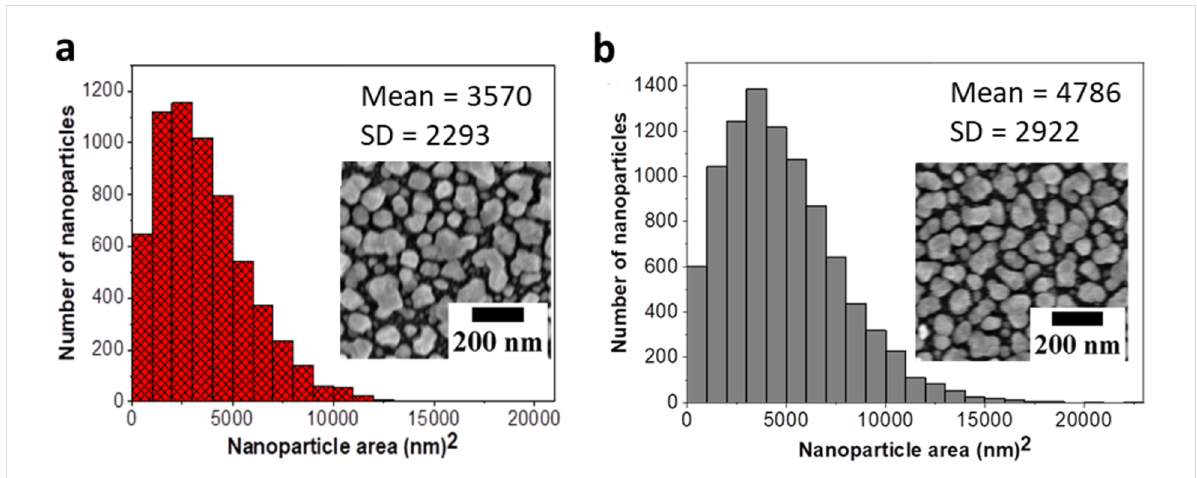
Figure 2: Particle size distributions and SEM images of the microwave-fabricated SERS substrates (a) after synthesis and (b) after immersion in water for 1 h. Data were acquired on different substrates prepared in different batch synthesis processes ( n = 5). The nanoparticle area represents the projected area occupied by an averaged